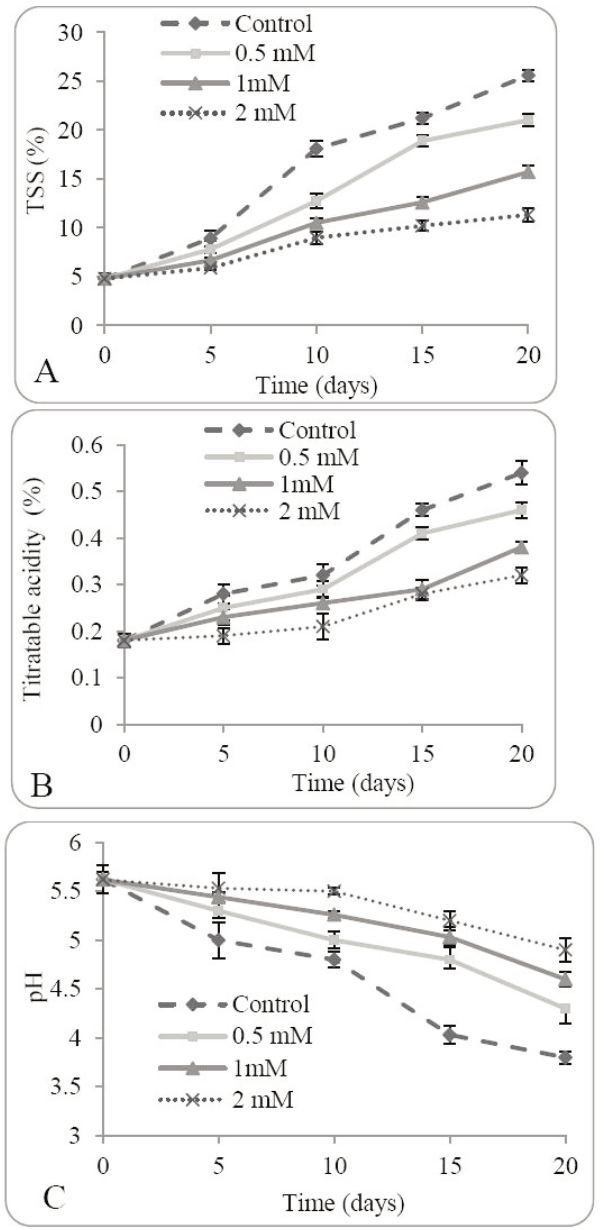
Fig. 3 - The effect of putrescine at different concentrations (0.5, 1 and 2 mM) on TSS (A), TA (B) and pH (C) of Musa acuminata L. during